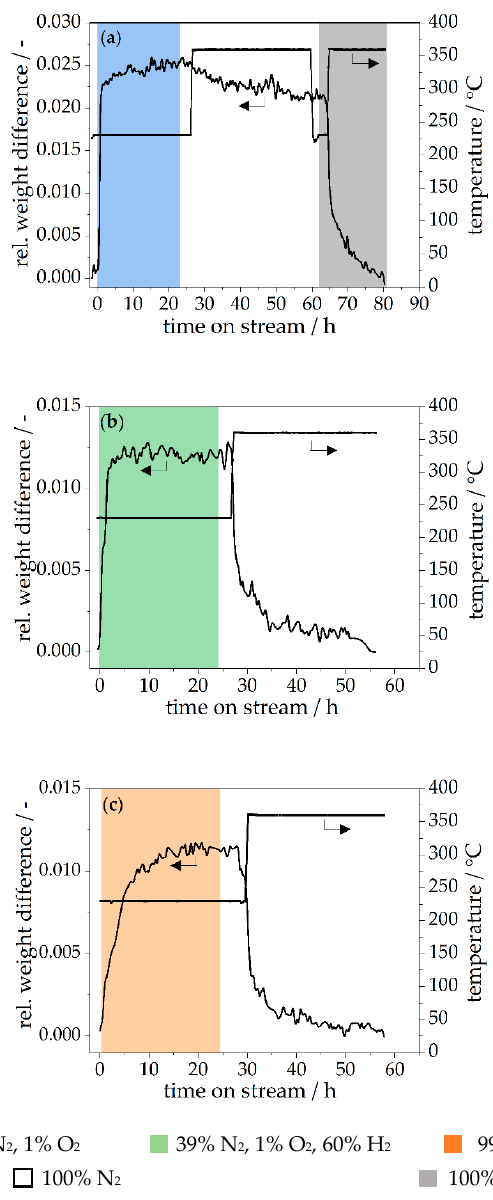
Figure 2. ( a ) Stability of catalyst in O 2 -containing N 2 gas feed without H 2 present. ( b ) Stability of catalyst in O 2 -containing N 2 gas feed with H 2 present. ( c ) Stability of catalyst in H 2 O-containing N 2 gas feed (magnetic suspension balance). Conditions: T = 230–360 °C; p = 10 bar; 𝑉(cid:4662) total = 13 L/h (NTP); p H2 = 0–10 bar, p N2 = 0–10 bar; p O2 = 0–0.1 bar; p H2O = 0–0.1 bar; m cat (Co/Pt/Al 2 O 3 ) = 0.5–1 g. Table 1 summarizes the results: The weight gain caused by catalyst oxidation (case a) remains at around 2.5% at 165 ◦ C, revealing that almost all cobalt atoms are then already oxidized to CoO. In case of a H 2 /O 2 gas mixture (case b), the weight gain depends on temperature and is by a factor of two lower at 165 ◦ C than at 230 ◦ C. This trend also confirms H 2 O adsorption (in a H 2 /O 2 gas), as the (exothermic) adsorption is in general favored by a lower temperature. In both cases, the mass increase can be undone by drying in pure N 2 at 360 ◦ C, confirming that the catalyst weight increase in a H 2 /O 2 gas feed is due to surface adsorption of H 2